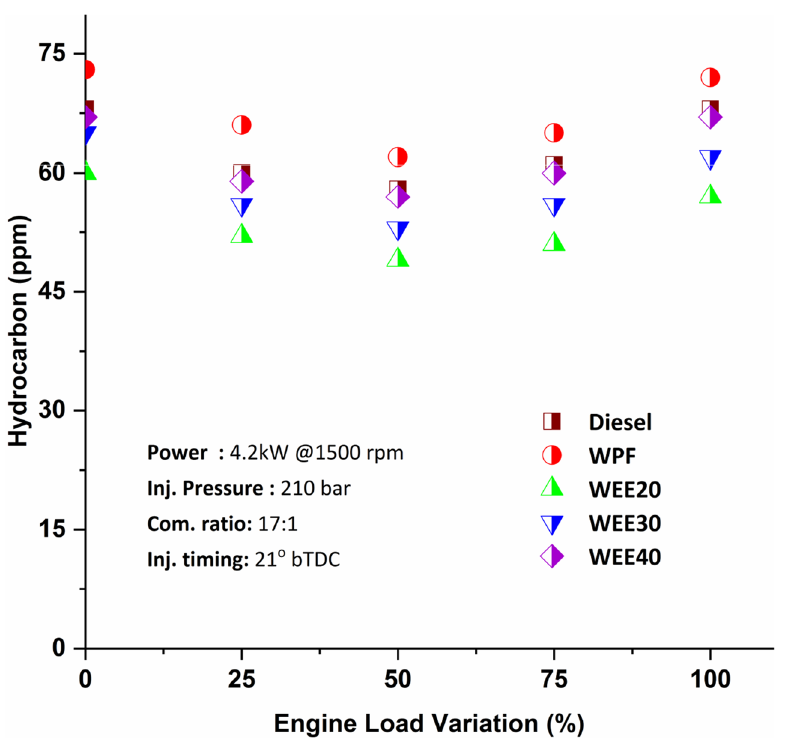
Figure 6. Variation of hydrocarbon emissions on engine